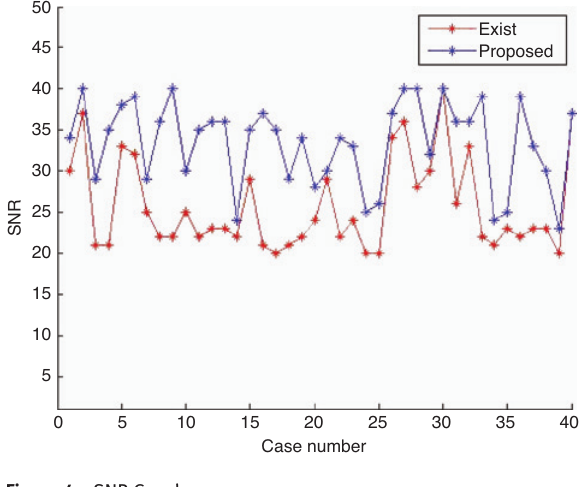
Figure 4: SNR Graph.